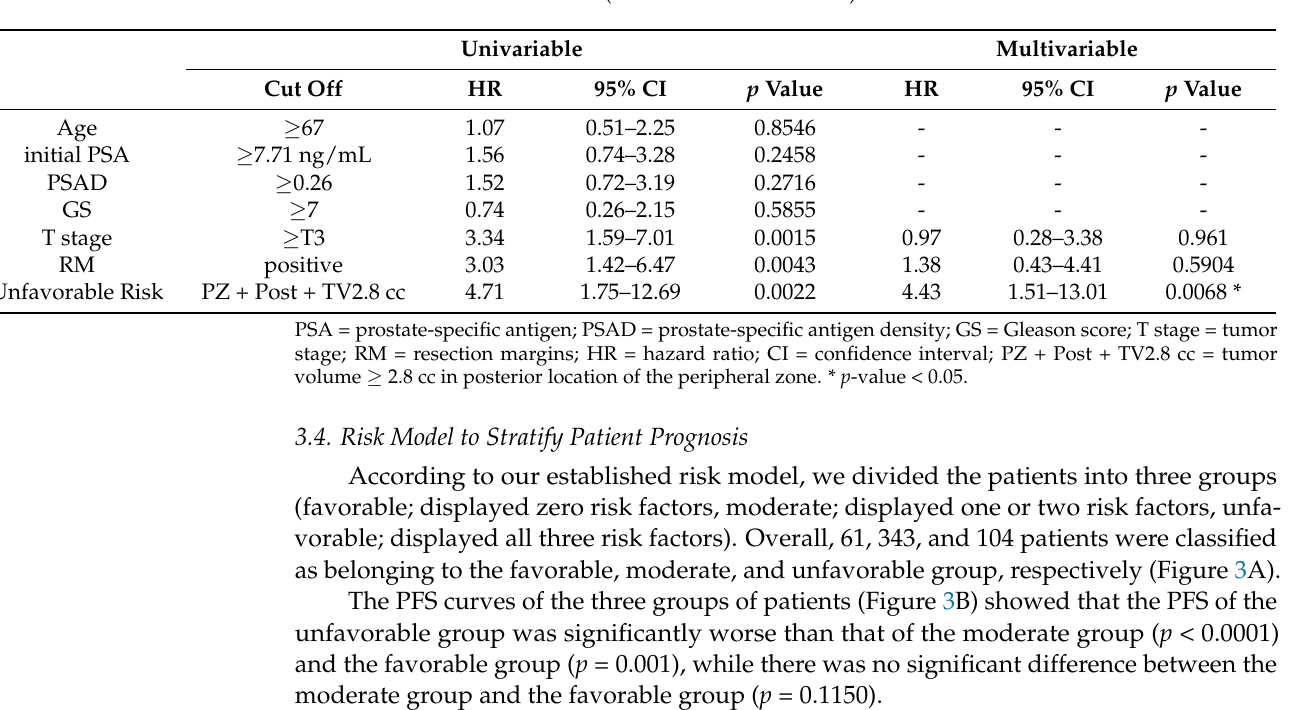
Table 5. Univariable and multivariable cox proportional hazard regression models in predictive factors for PFS in localized Pca (low to intermediate